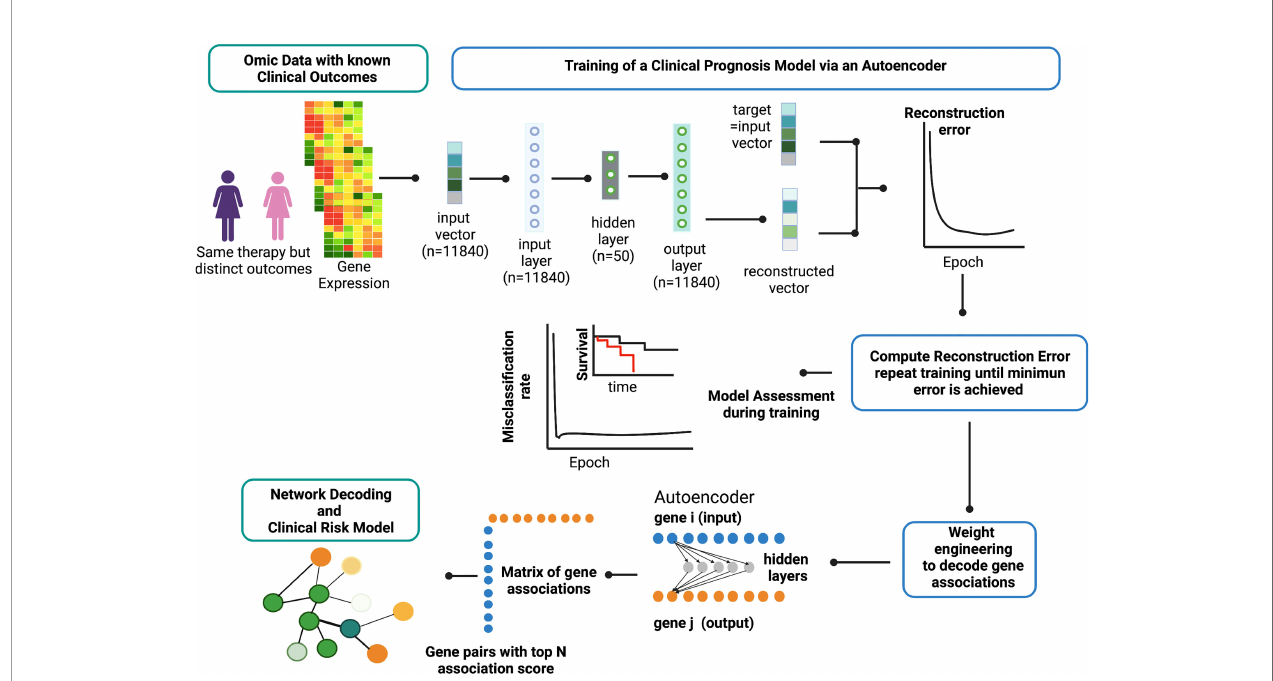
FIGURE 2 | Overview of Arti fi cial Neural Network Encoder (ANNE). The ANNE algorithm uses gene expression pro fi les from breast cancer patients with known prognostic outcomes to simultaneously decode gene-gene associations, networks and derive clinical risk models. Patient samples are assigned to either good or poor prognosis according to disease relapse-free survival (DRFS). Next, an autoencoder algorithm is used to train the models, with an input vector that represents all genes (features) present in transcriptomics data and each gene corresponds to a node in the input layer. The dimensionality of the output layer (i.e., number of nodes) is the same as the input layer. The autoencoder has an architecture of one input layer, one hidden layer and one output layer. During the training phase the autoencoder reconstruct values from input layer into an output layer and the output vector is compared with input vector to compute the reconstruction error. The training process is repeated by updating weights connecting nodes (or neurons) from input layer to hidden layer and from hidden layer to output layer via a backpropagation algorithm. The training process is repeated by feeding input through the neural network to the output layer to calculate the training loss, and updating the weights connecting nodes from the output layer to hidden layer and to the input layer via a backpropagation algorithm. Training process is deemed complete when no further improvements on the reconstruction error is achieved, or training has reached certain number epochs. Next, the learned weights connecting all nodes from input to output layers in a trained autoencoder model are used to decode meaningful gene-gene associations using an association scoring scheme. Computed association scores for all gene pairs are aggregated to an association score matrix and the top gene pairs (n=200) with highest absolute scores are selected to build ANNE-decoded networks. Genes that occur multiple times will serve as “ anchors ” to agglomerate gene pairs into a network. Figure generated with